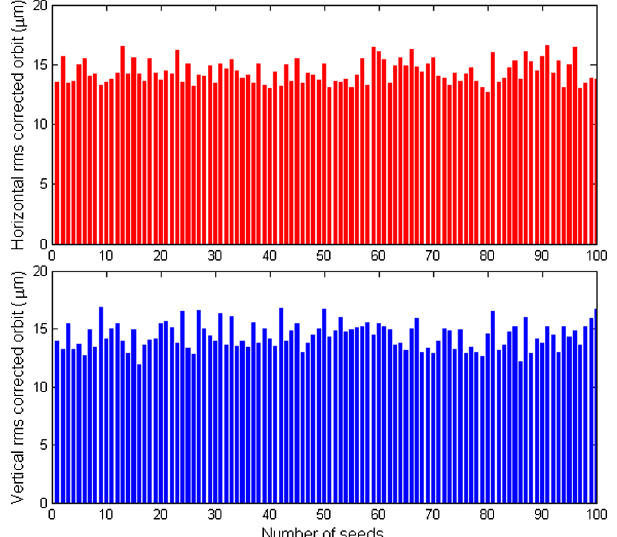
FIG. 10. The rms values of the corrected closed orbits for 100 seeds of random errors: (top) horizontal orbit, (bottom) vertical orbit.